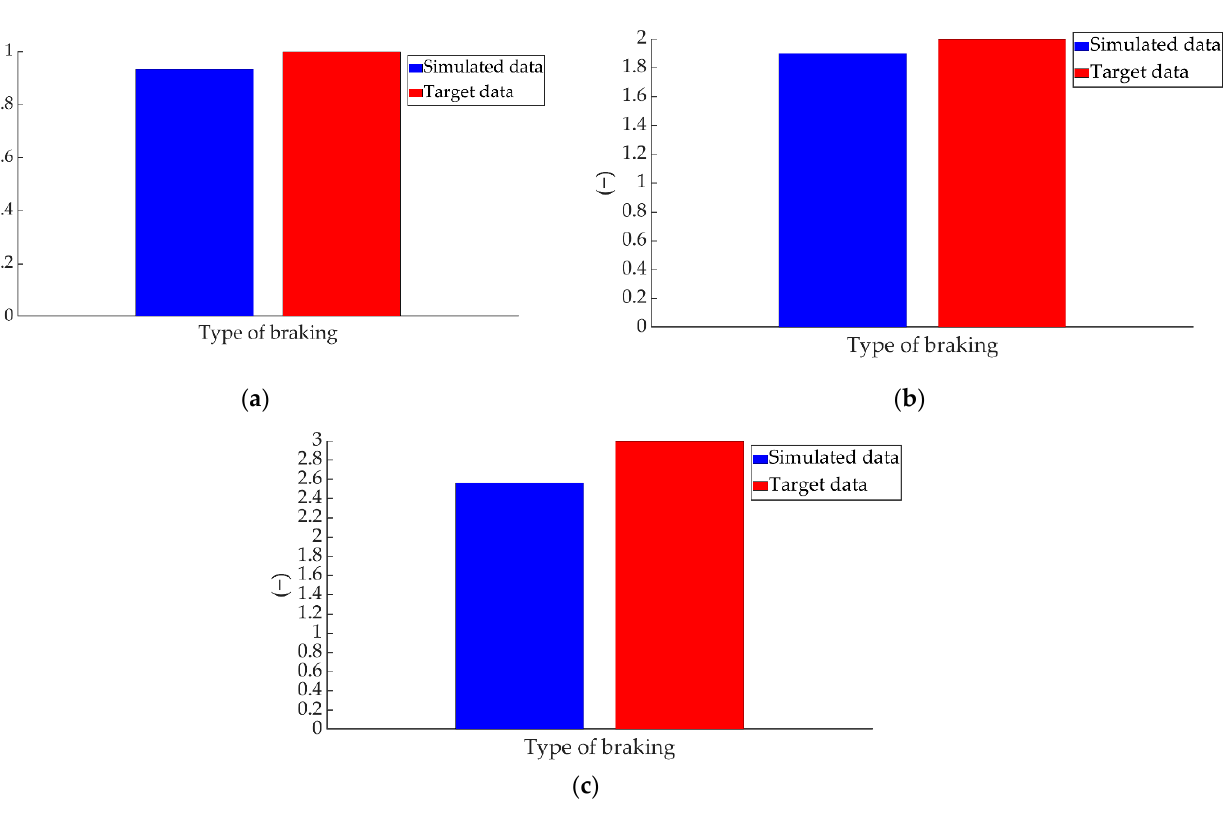
Figure 23. Comparison between the ANN-simulated data and target braking type data for braking at a speed of 70 km/h for the type: ( a ) maintained, ( b ) progressive and ( c ) emergency. As mentioned above, the simulations were performed randomly over the whole range of test speeds and braking manoeuvres. In the following, the errors derived from the braking system parameters are shown in comparison with the empirical data. Table 5 shows the target values for braking type and q t for the two pressure sensors, the data simulated by ANN for the above parameters and the error of these values compared to the target